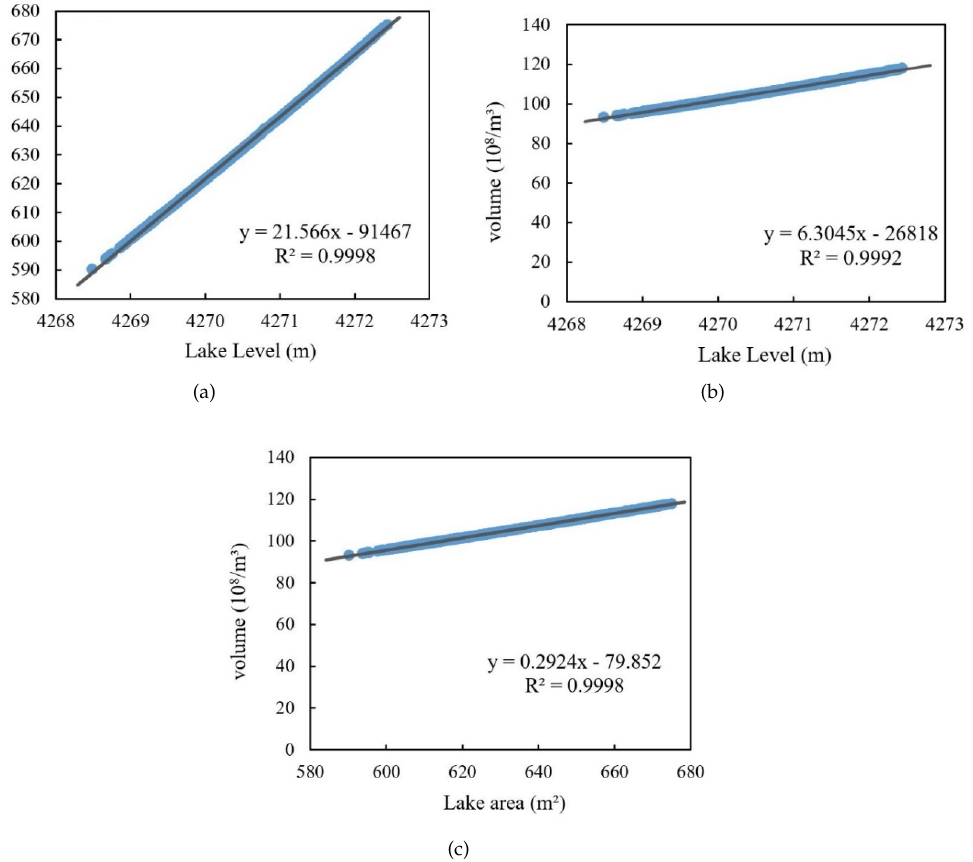
Figure 11. Correlation evaluation of the surface area, water level, and water storage capacity of Ngoring Lake.